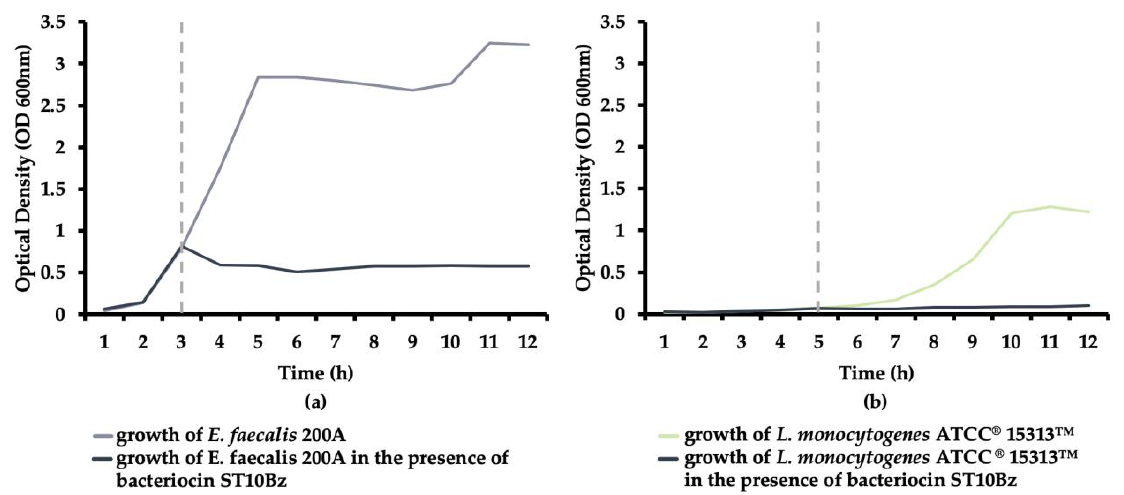
Figure 3. Bactericidal mode of action of the bacteriocin produced by E. faecium ST10Bz against ( a ) E. faecalis 200A, and ( b ) L. monocytogenes ATCC ® 15313 ™ ; dotted lines represent the initial exposure to the bacteriocin. All data represent an average of three repeats. The OD values recorded in each experiment did not differ by more than 5% variation and standard deviation values were not presented.